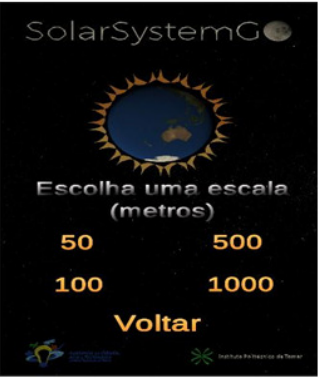
Figure 10. Four options of scale: 50 m, 100 m, 500 m or 1000